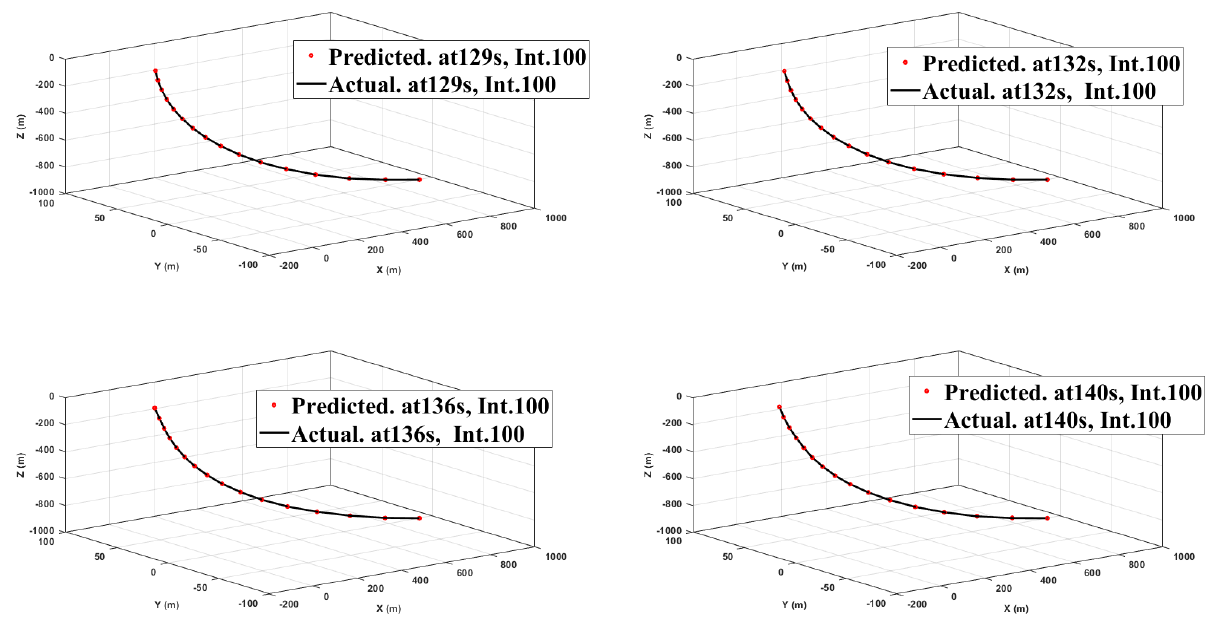
Figure A1. Node Displacement Tracing, Snapshots, 100-yr storm, WD1000, SCR, Entire Arc Length.